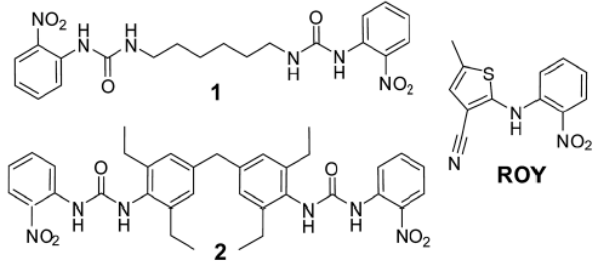
Figure 9. Structure of ROY and supramolecular gel monomers [95]. Reproduced by permission of The Royal Society of Chemistry (UK).